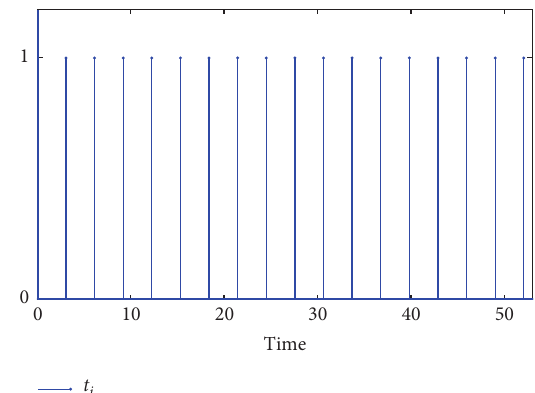
Figure 4: The starting instant of each control of the observer-based T-APIC.